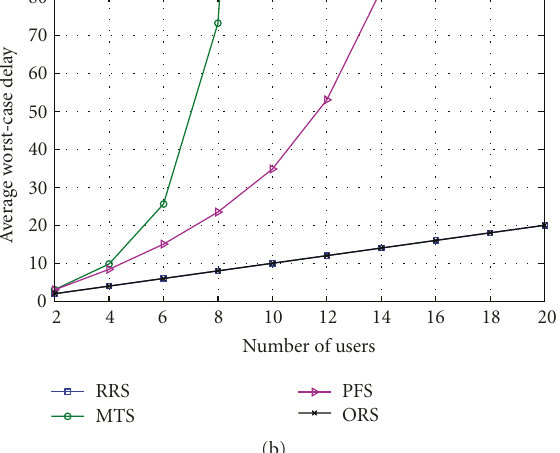
Figure 4: Average sum rate/worst-case delay tradeo ff , n T = { 1,2 } ; K = 4; SNR = 20